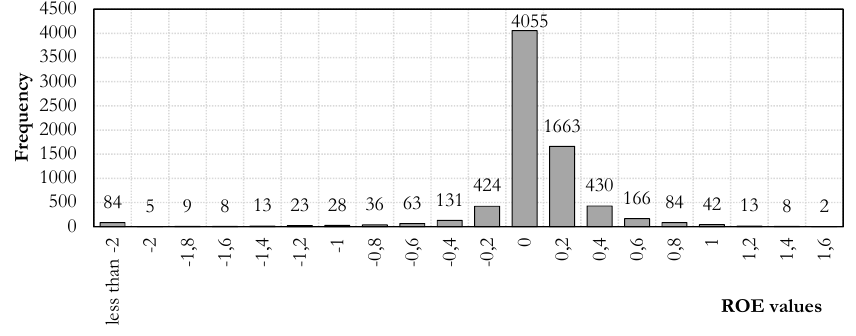
Fig. 2 – Histogram of ROE. Source: Own